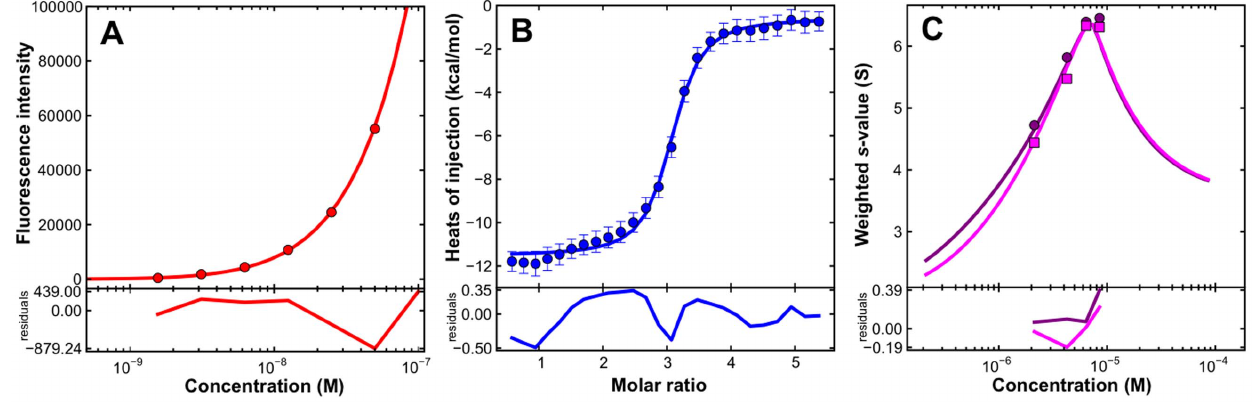
Figure 4. The interaction of the Fab 8066 with 3-H. Solid lines show the global best-fit to a non-cooperative A + B + B + B interaction in which the trimer A has three symmetric binding sites. A global analysis of the data results in a K d1 affinity of 4.3 nM. (A) Binding affinity of Fab 8066 to the 3-H. Corrected fluorescence intensity differences (325–355 nm) as a function of the complex concentration in a dilution experiment using a (Fab 8066) 3 /3- H trimer complex previously characterized by sedimentation velocity (Fig. X1C). (B) Binding enthalpy of Fab 8066 to the 3-H. Isothermal titration calorimetry data for the titration of 19 m M Fab 8066 into a solution containing 1.77 m M trimer. (C) Interference s w isotherm (magenta) and absorbance s w (purple) isotherm (Fig. 2A) data along with the best-fits obtained in a global analysis of the data sets shown.